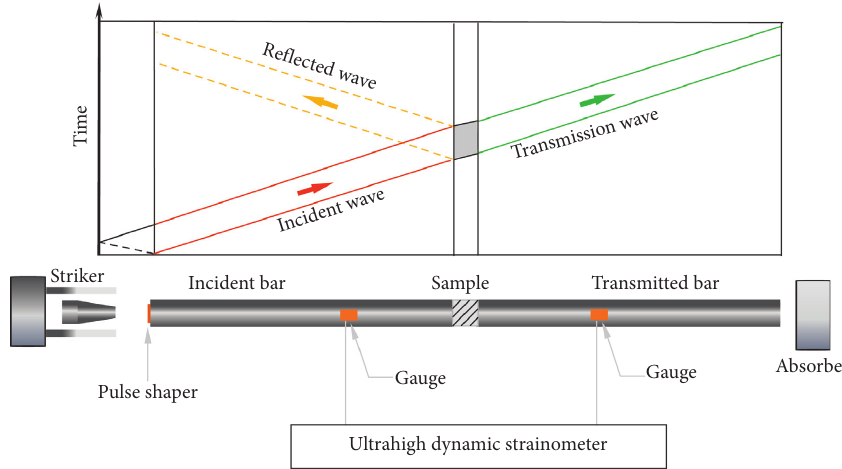
Figure 3: SHPB system and stress wave propagation situation.